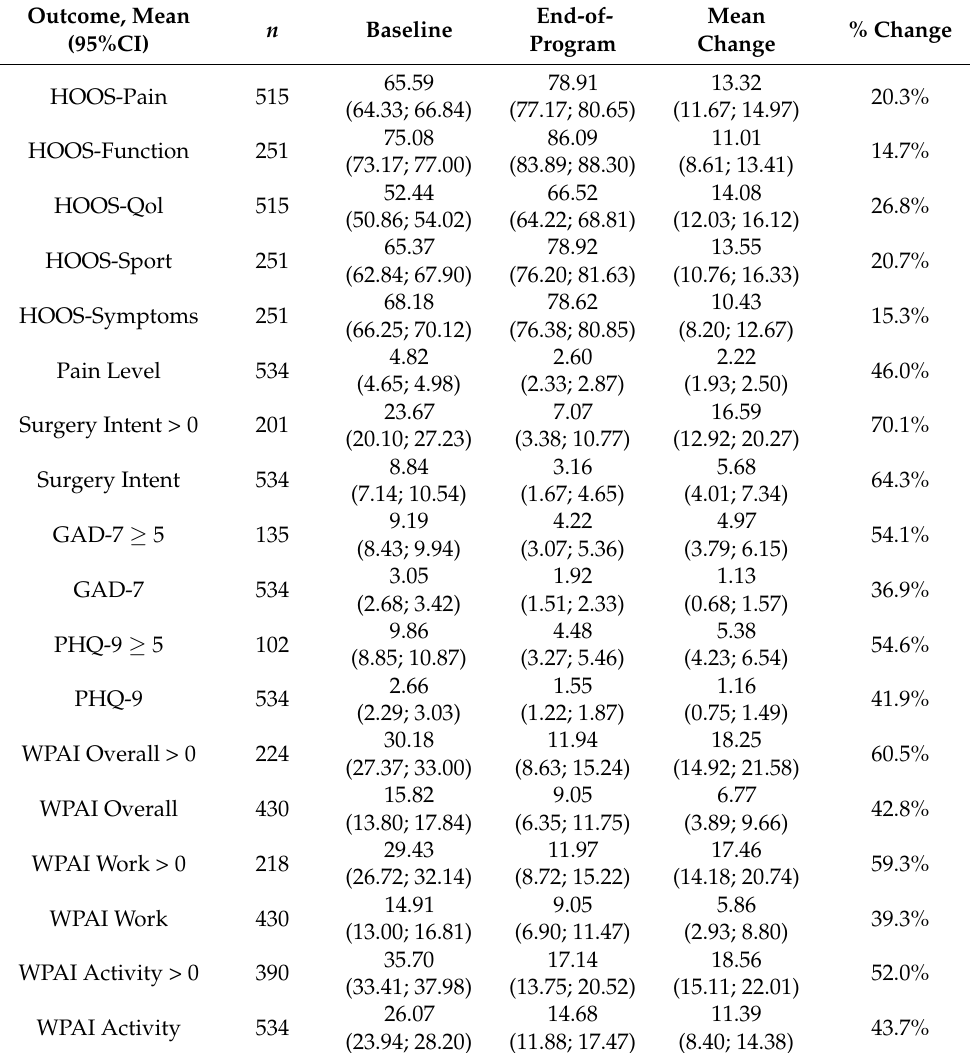
Table 2. Outcome changes between baseline and end-of-program: Intent-to-treat approach (uncondi- tional